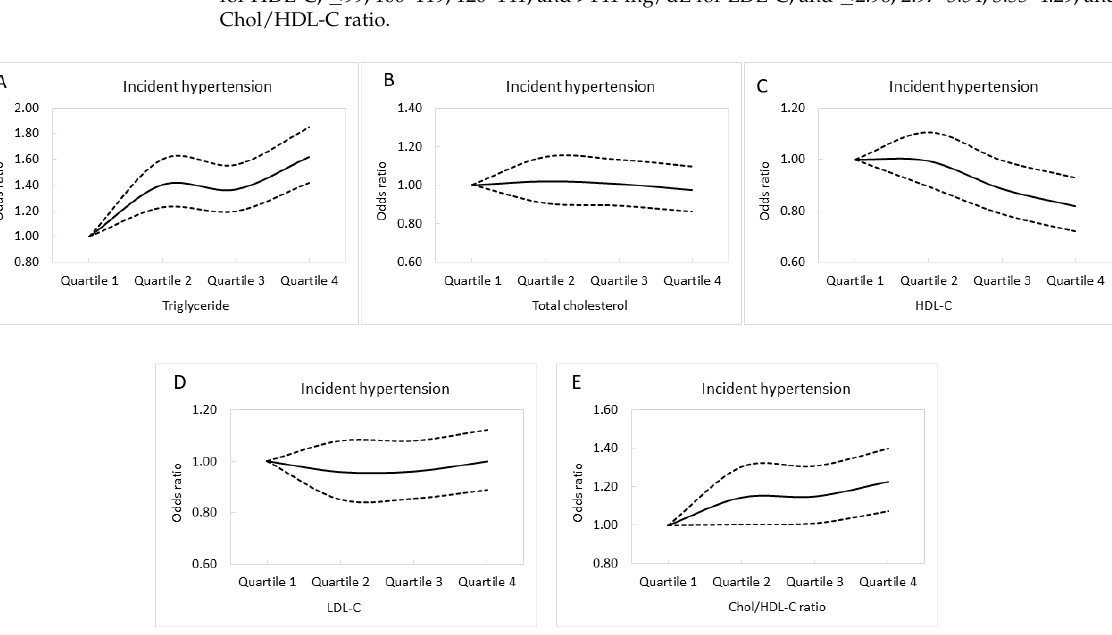
Figure 3. Adjusted incident hypertension curves for triglycerides ( A ), total cholesterol ( B ), HDL-C ( C ), LDL-C ( D ), and Chol/HDL-C ( E )